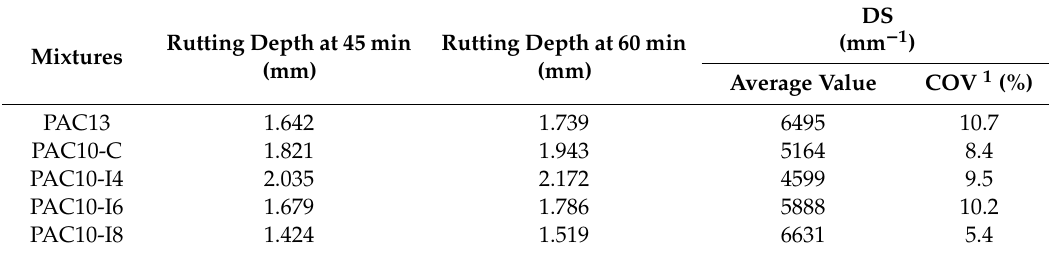
Table 6. Rutting test results.